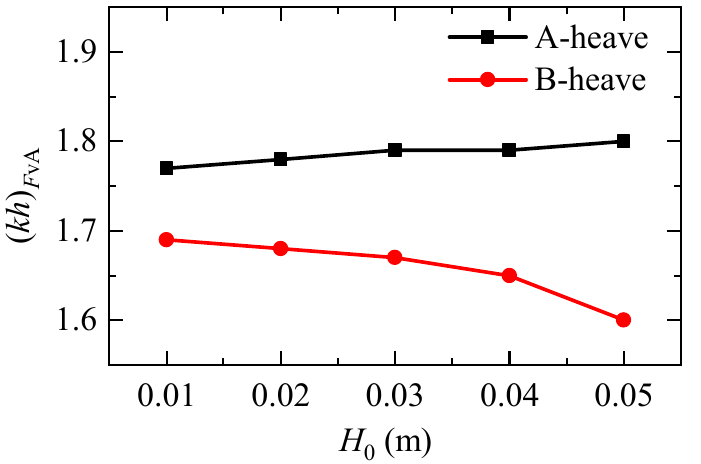
Figure 12. Variations of ( kh ) F vA with respect to the incident wave height for both structure systems.